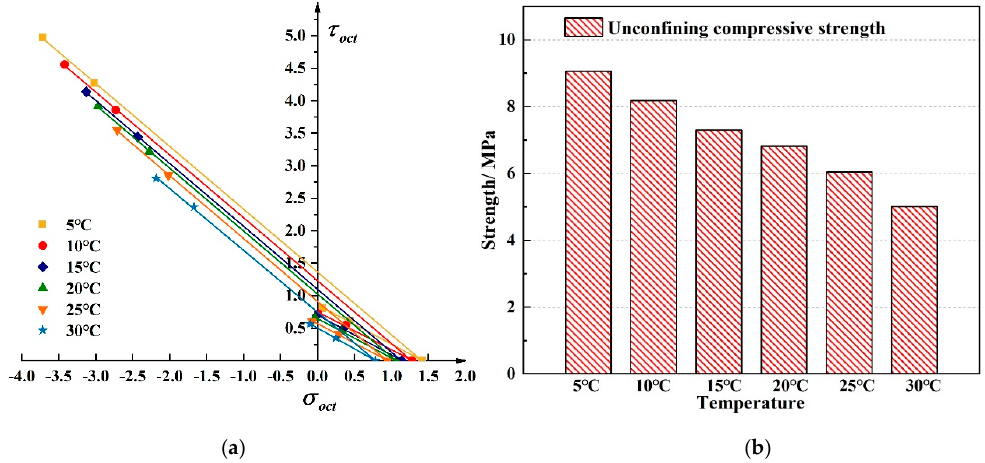
Figure 10. Linear compressive and tensile meridian under different temperature. ( a ) The compressive and tensile meridian under six different temperatures ( b ) The strength comparison between six different temperatures.